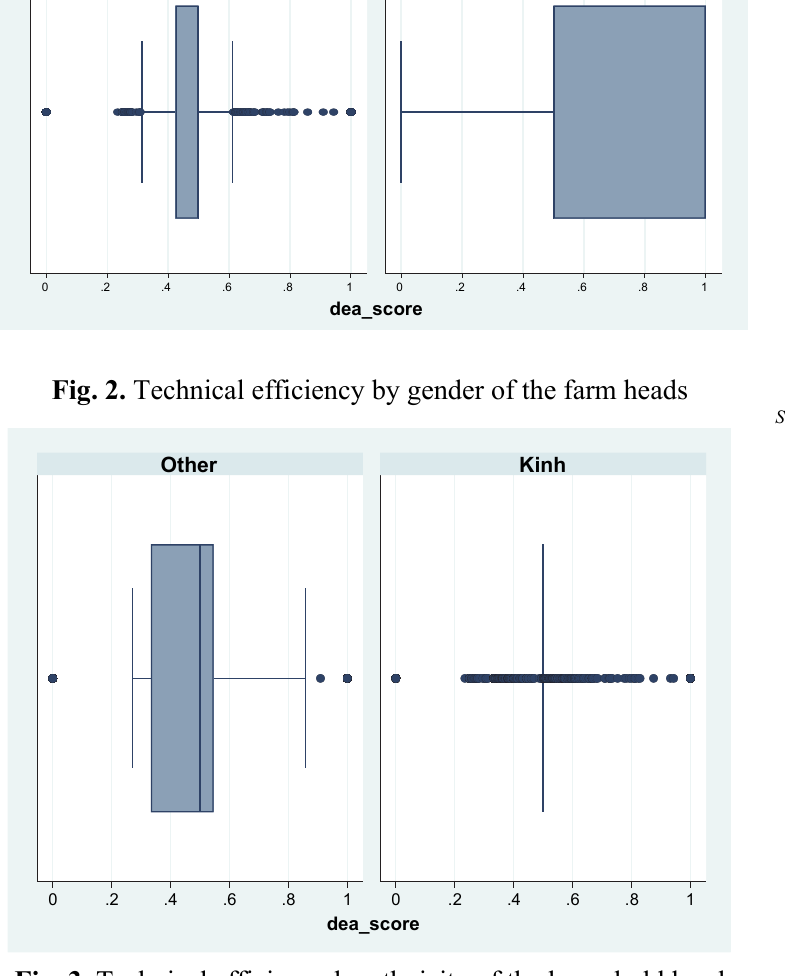
Fig. 3. Technical efficiency by ethnicity of the household head